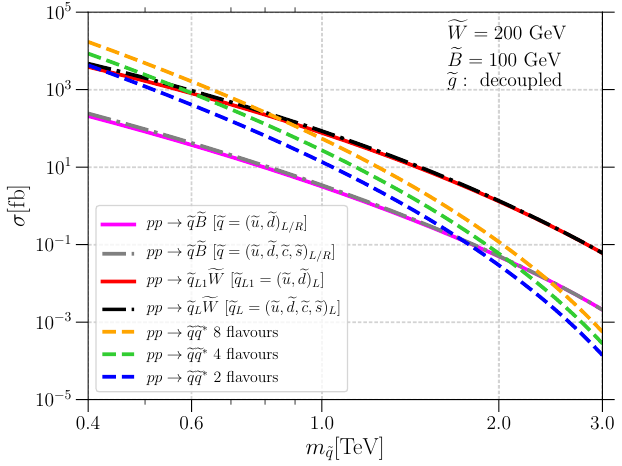
Figure 2 . The cross sections for various production channels as a function of the produced squark